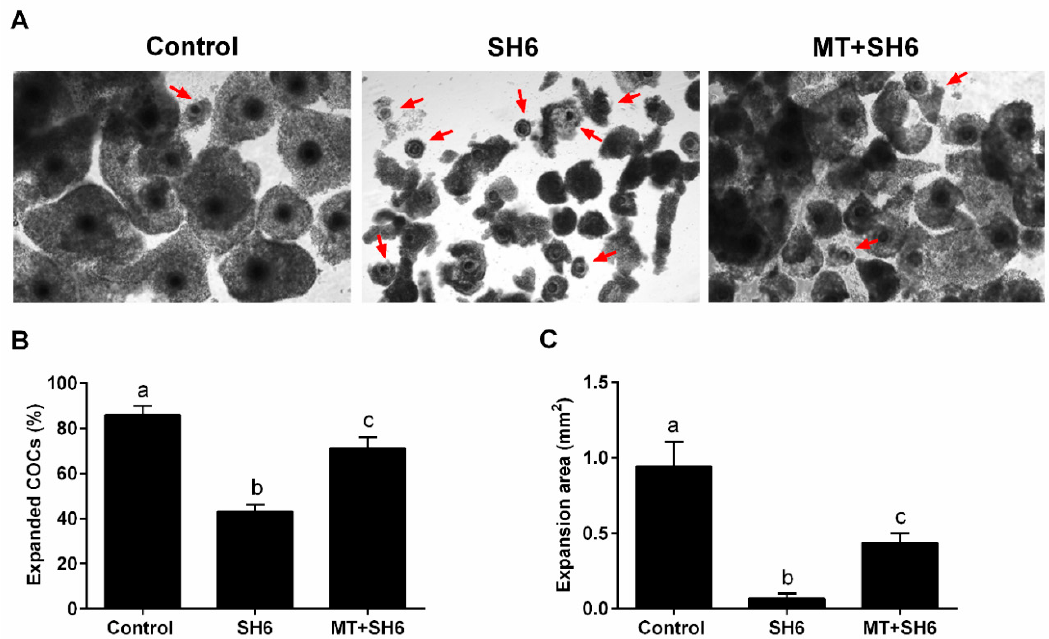
Figure 4. Morphological determination of cumulus cells expansion during in vitro maturation. ( A ) Light microscopy images of day 1 cumulus oocyte complexes (COCs) matured in vitro. Red arrows indicate non-expanded COCs; ( B ) Quantification of expanded COCs; ( C ) The increase in the expansion area of COCs. Different superscript letters indicate statistically significant difference ( p < 0.05). Original magnification 40×.